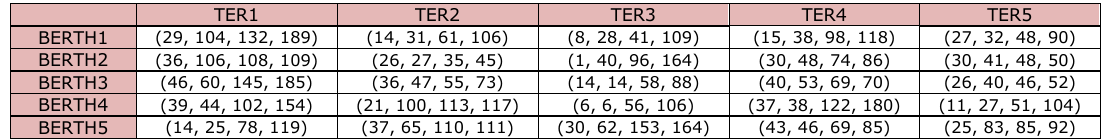
Table 3. “Distance between Berth b and Terminal area j for I containers”.